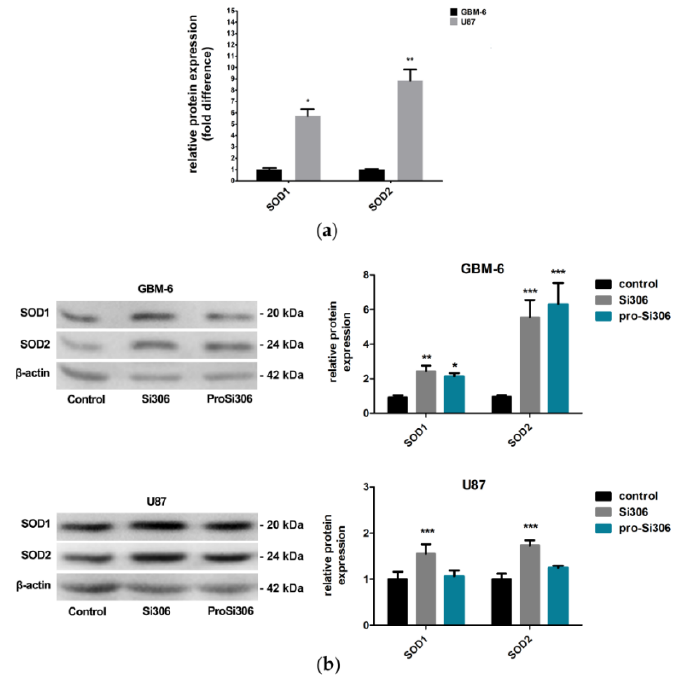
Figure 4. Si306 and pro-Si306 change the protein expression of antioxidant enzymes in glioblastoma cells. ( a ) Difference in protein expression levels of SOD1 and SOD2 between GBM-6 and U87 cells. The protein expression levels are presented as fold-difference compared to GBM-6 cells. The histogram represents Western blot data expressed as protein levels normalized to β -actin. Values are expressed as mean ± SD ( n = 3). A statistically significant difference between GBM-6 and U87 cells is shown as * ( p < 0.05) and ** ( p < 0.01). ( b ) Representative Western blot images of superoxide dismutase 1 (SOD1) and superoxide dismutase 1 (SOD2) protein expression in GBM-6 and U87 cells after 24 h treatment with 10 µ M Si306 and pro-Si306 are shown on the left panel. Quantification of protein expression levels of SOD1 and SOD2 in control cells and upon treatment is shown on the right panel. Histograms represent Western blot data expressed as protein levels normalized to β -actin. Values are expressed as mean ± SD ( n = 3). A statistically significant difference between treated and control group is shown as * ( p < 0.05), ** ( p < 0.01) and *** ( p <